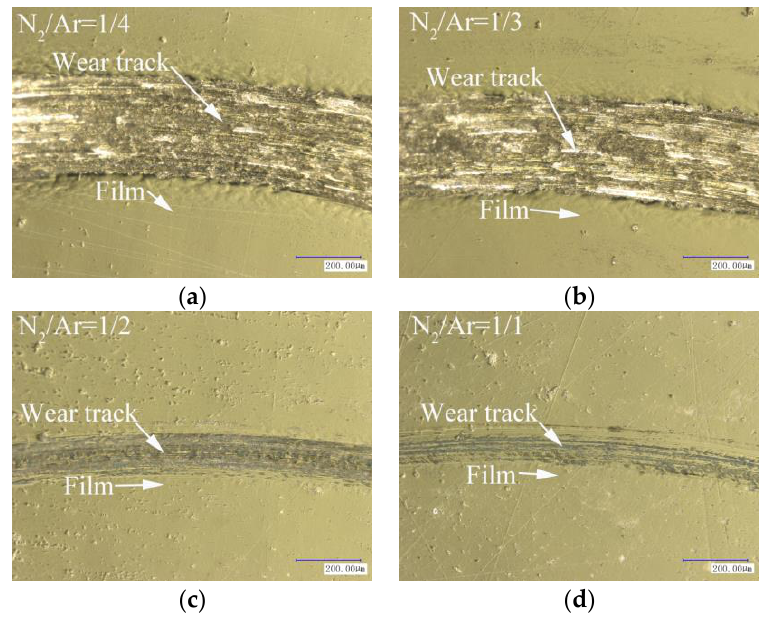
Figure 8. The wear morphology of the AlCrSiN coatings as a function of N 2 /Ar flow ratio: ( a ) N 2 /Ar = 1/4; ( b ) N 2 /Ar = 1/3; ( c ) N 2 /Ar = 1/2; ( d ) N 2 /Ar = 1/1.